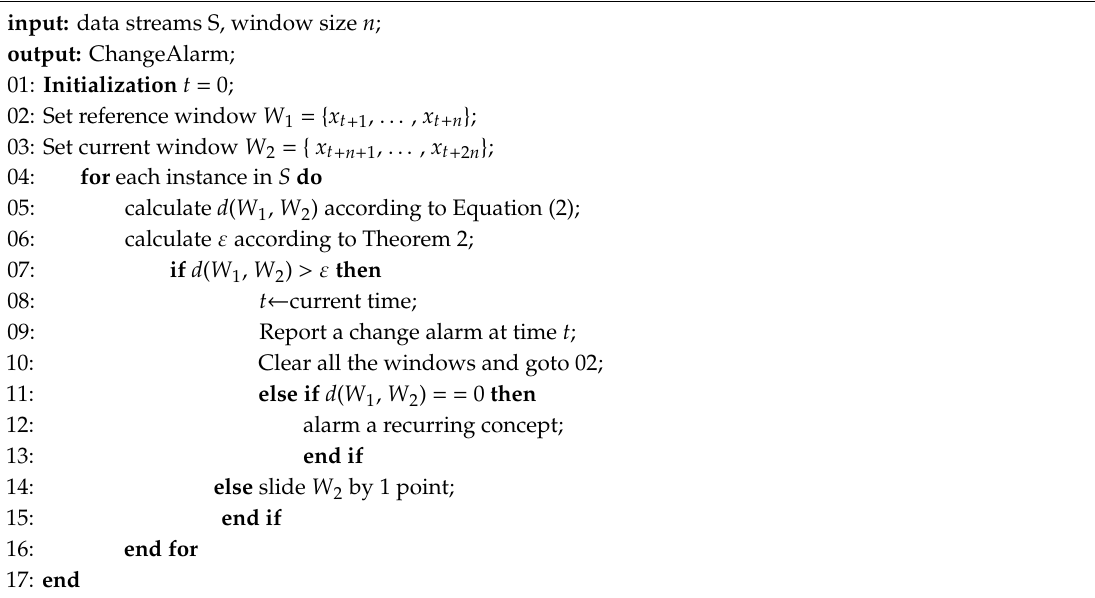
Algorithm 1 Two-windows-based change